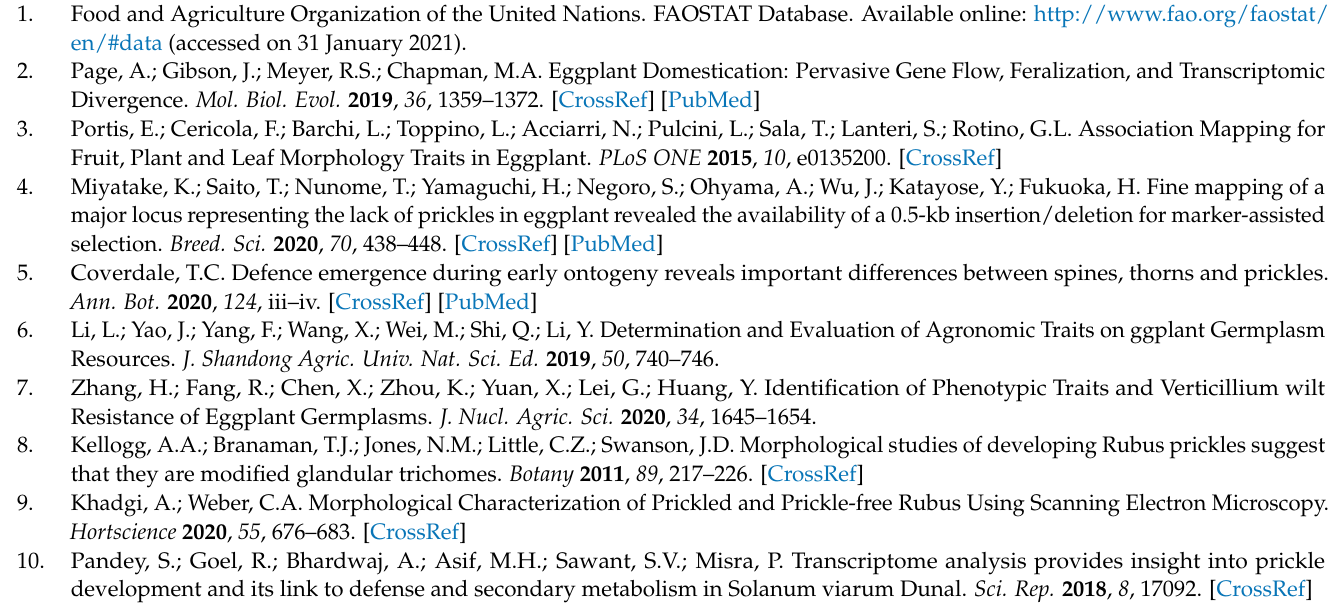
mentary Table S10: Putative transcription factors involved in prickle development, Supplementary Table S11: List of DEGs within the Pl locus interval, Supplementary Table S12: Primers used for qRT-PCR, Supplementary Figure S1: Light micrographs of prickles and trichomes on the stem of prickly eggplant, Supplementary Figure S2: Heatmap of Pearson’s correlation coefficients between all pairs of samples, Supplementary Figure S3: GO enrichment analysis of DEGs identified in the pairwise comparisons, Supplementary Figure S4: Heatmap showing the expression patterns of the DEGs involved in biological processes during the development of prickles, Supplementary Figure S5: Heatmap showing the expression patterns of the differentially expressed TFs involved in the development of prickles, Supplementary Figure S6: Heatmap analysis of the genes within the Pl locus